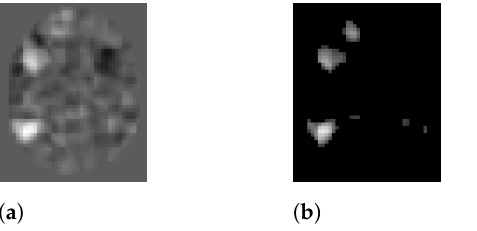
Figure 2. Visualization of two forms of image data for Language network (LANG): ( a ) connectivity map image, ( b ) Thresholded